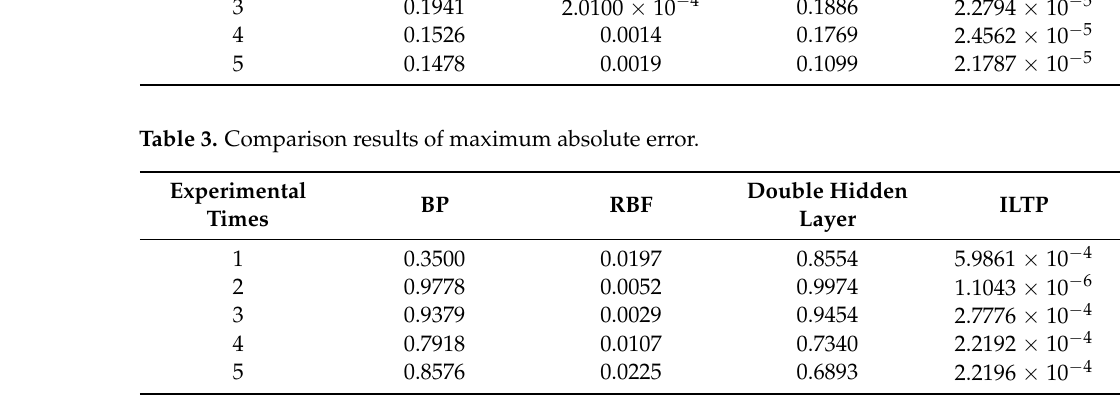
Figure 10. Two-dimensional Henon error iterative convergence curve. The blue line represents the